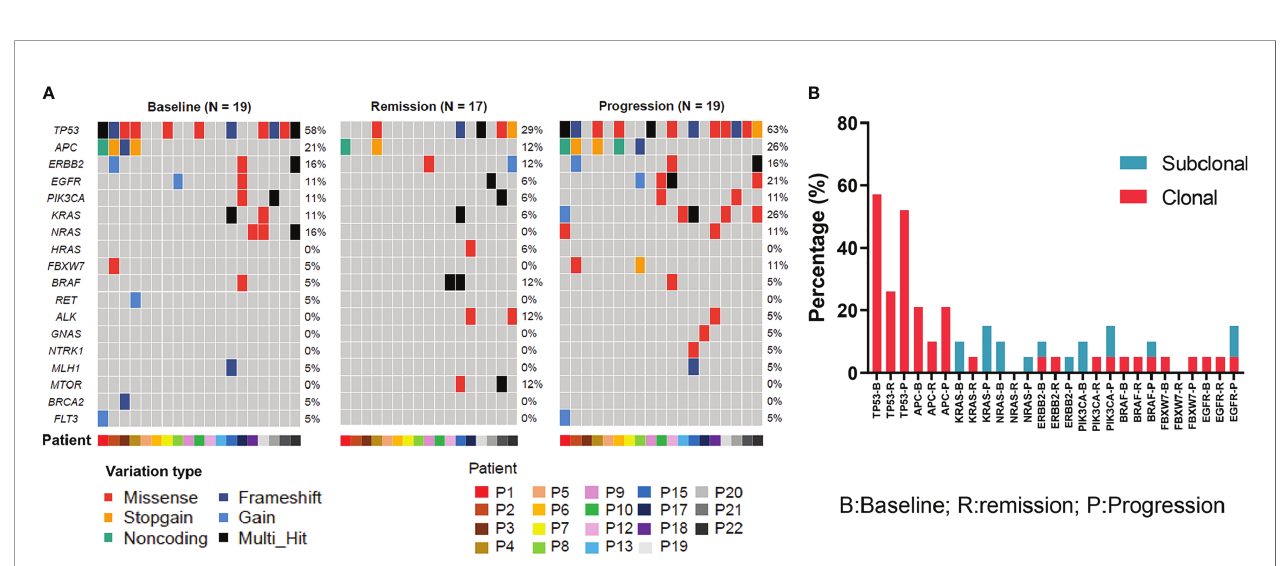
FIGURE 2 | Genomic features of ctDNA dynamically changed in colorectal cancer patients received anti-EGFR therapies. (A) The ctDNA genomic features for all specimens at baseline, remission, and progression in colorectal cancer patients who received cetuximab-targeted therapy. (B) The clonal and subclonal landscapes in mCRC patient at baseline, remission, and progression. Gain: segments with log ratio more than 3 times of standard deviation of all segment level were considered as “ gain ” .